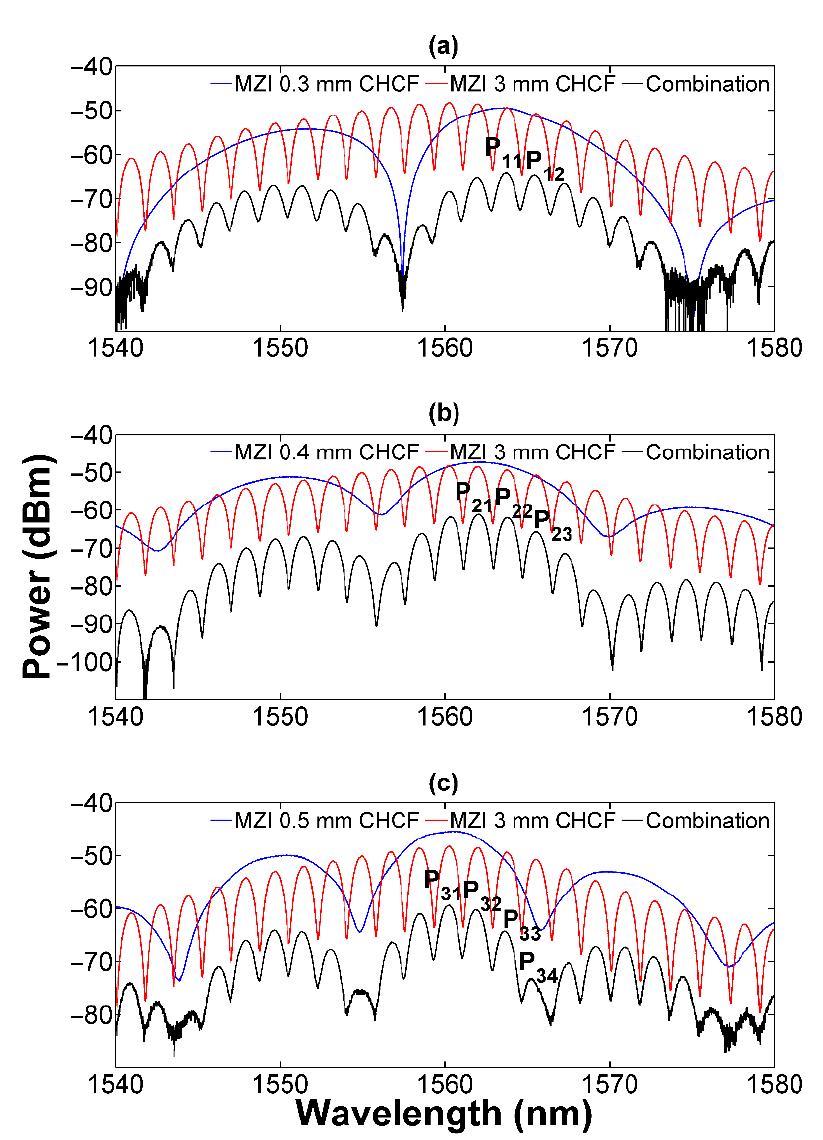
Figure 4. Measured transmission spectra of the MZI 2 connected in a series (Cascade configuration)